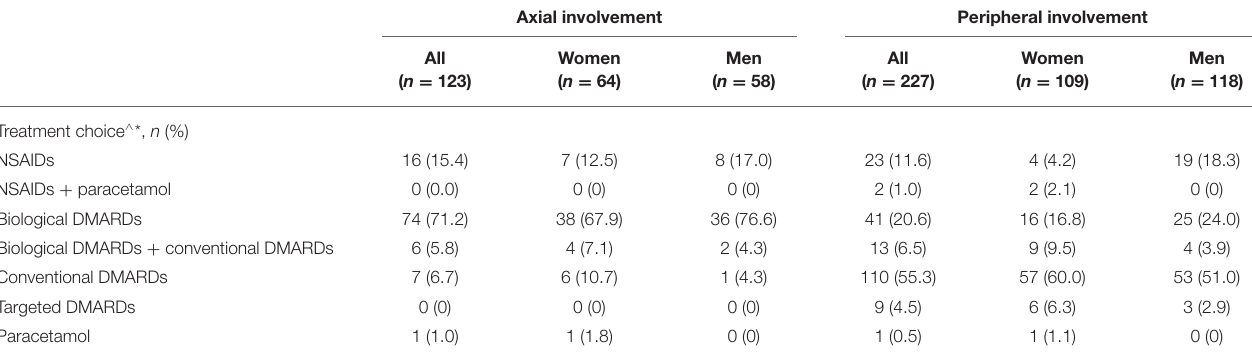
TABLE 4 | Treatment choice at baseline in the SIRENA study by involvement pattern and, in each subgroup, by gender ◦ . Axial